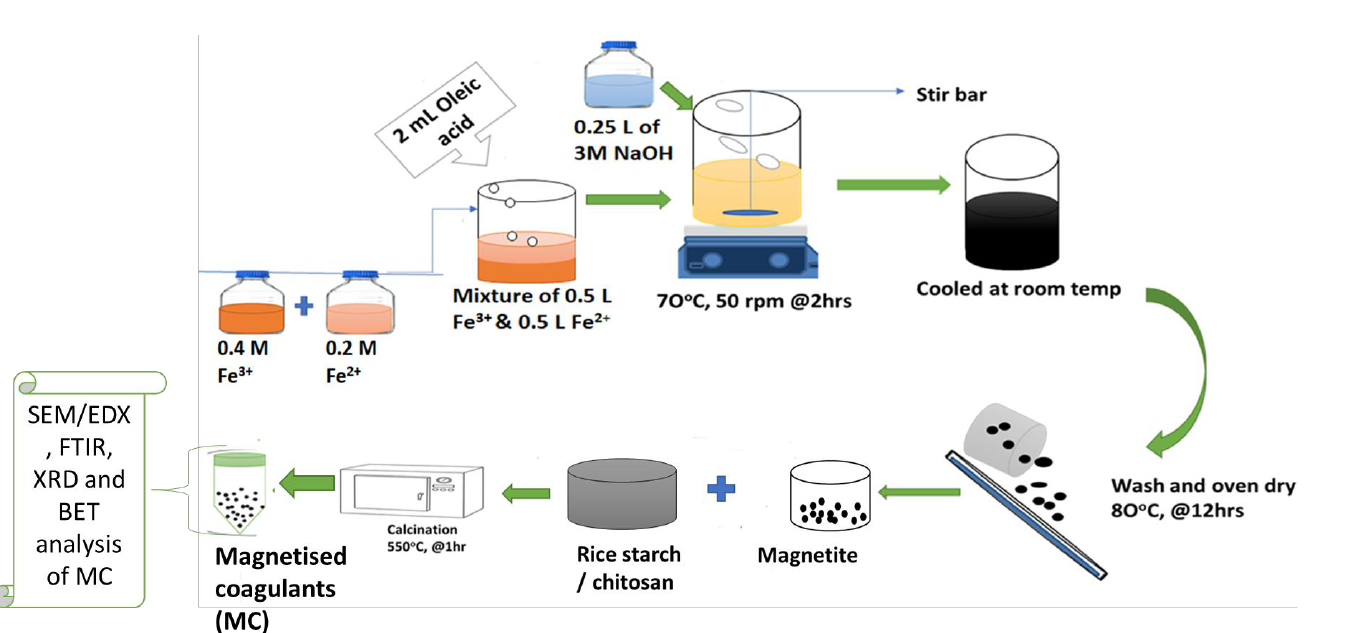
Figure 1. Schematic diagram of synthesizing magnetic coagulants. Table 3. Amounts measured for natural coagulant and magnetite to prepare 10 g of magnetized coagulants. Ratios of